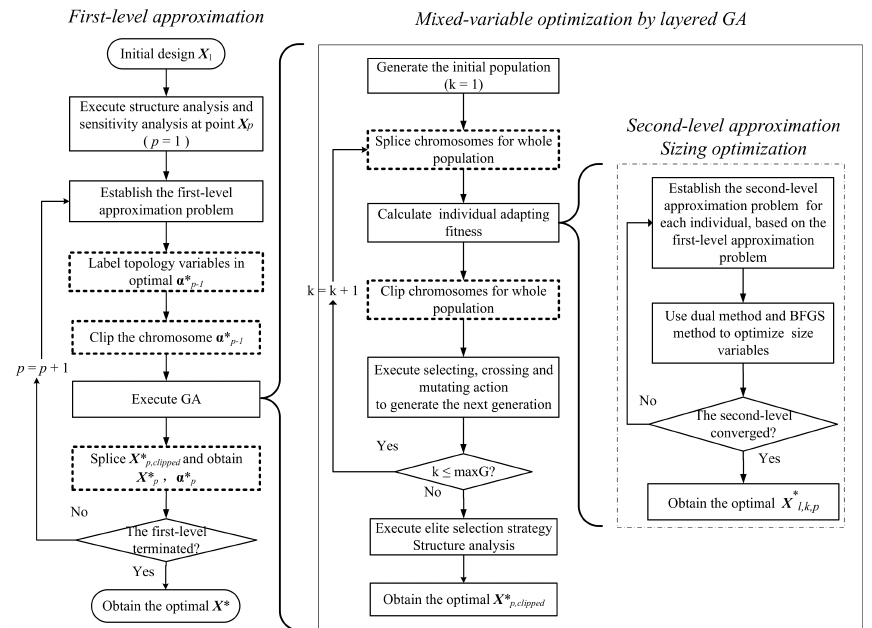
Figure 2. Optimization